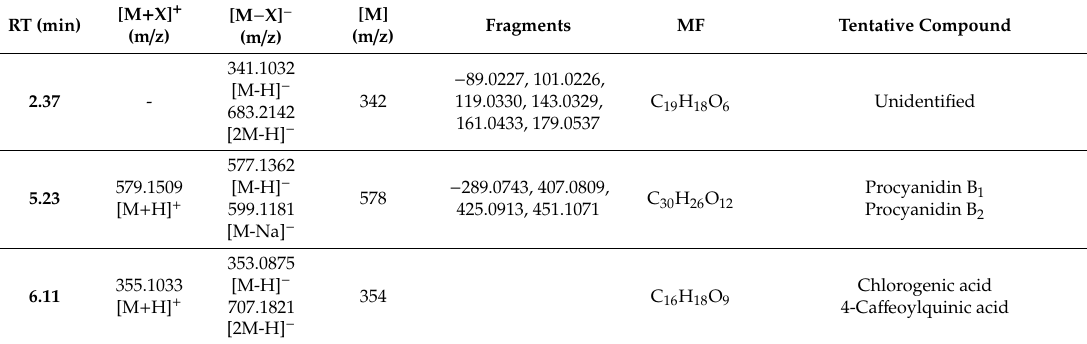
Table 7. Identification of compounds from peumo fruits by liquid chromatography coupled with mass spectrometry (LC-MS) and MS / MS data. The principal peaks were individually analyzed, and the potential compounds were analyzed. RT, retention time; MF, molecular